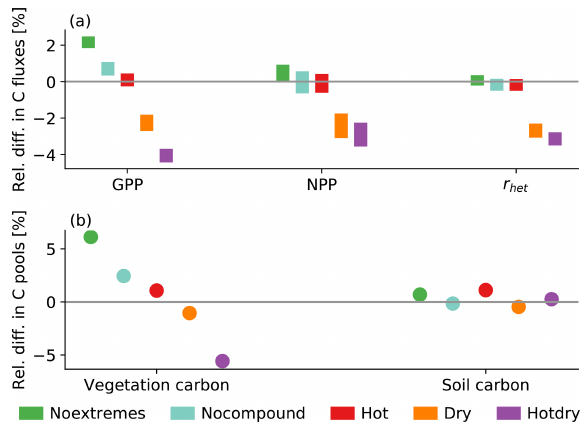
Figure 4. Relative difference in the scenarios from the Control sce- nario for (a) the global annual GPP, NPP, and heterotrophic respira- tion ( r het ) as well as (b) vegetation carbon and soil carbon. The bars in (a) show the minimum-to-maximum range of the 100-year-long simulations. Because the interannual range for carbon pools in (b) is very small, we only show the mean over the 100